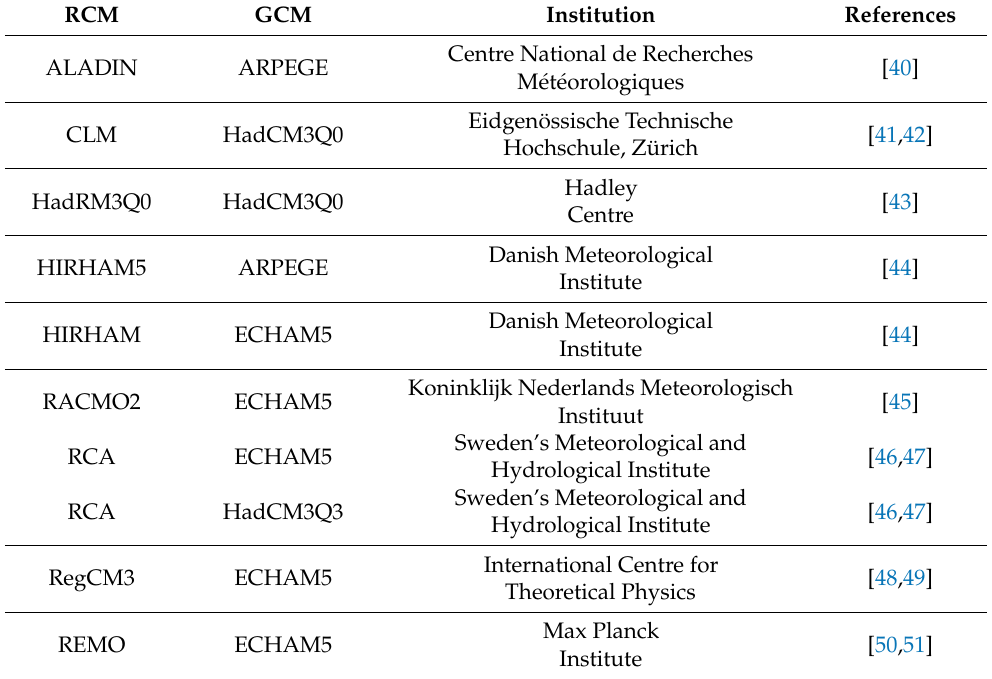
Table 1. The regional climate models (RCM) used in the FORESEE database, the global climate models (GCM) they are embedded in, and the institution where the coupled model runs were delivered. The horizontal resolution of the RCM data is 0.22 ◦ × 0.22 ◦